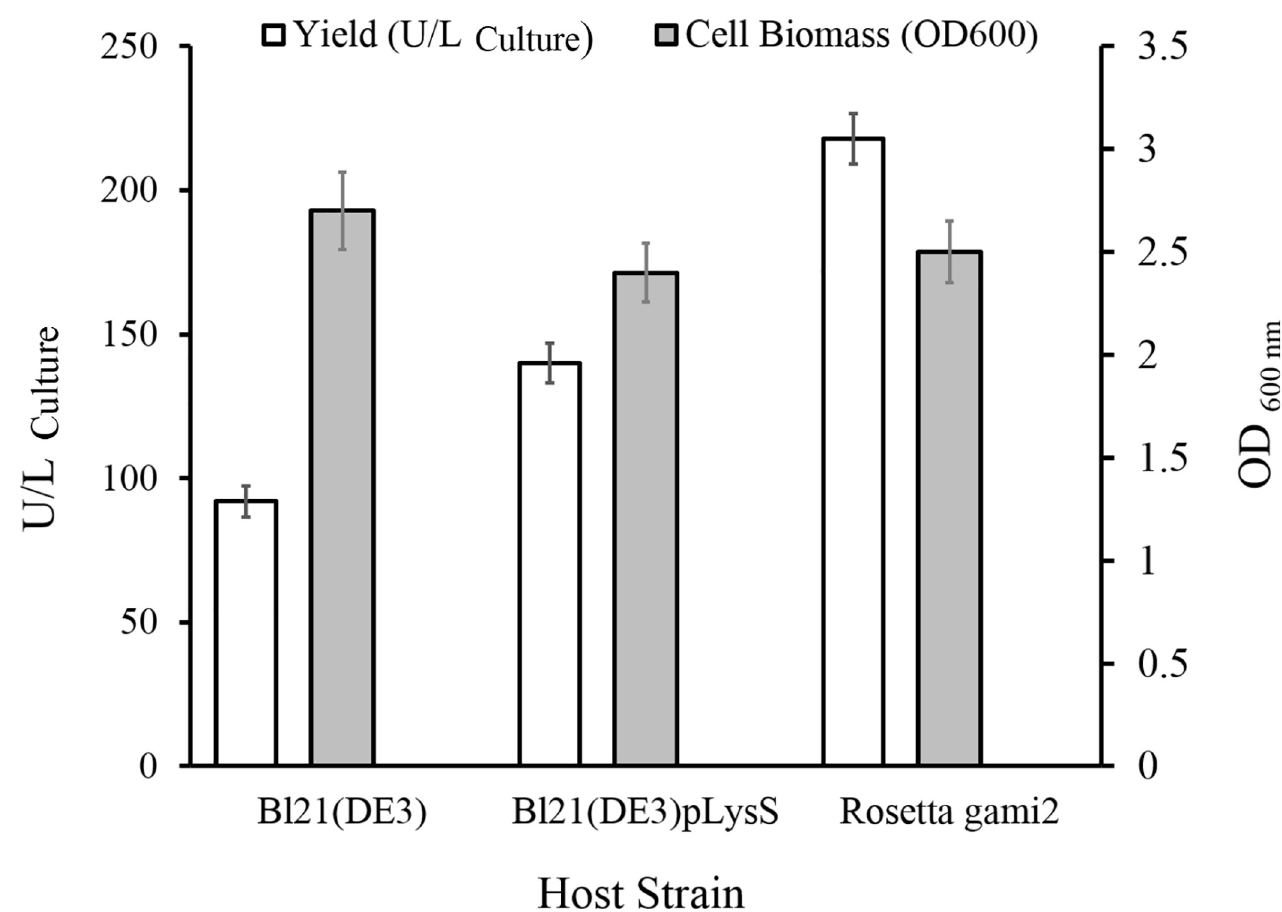
Fig 1. Cholesterol oxidase expression in various host strains. The influence of host strain on the recombinant enzyme yield and bacterial biomass accumulation was evaluated under 6-h cultivation at 37˚C.